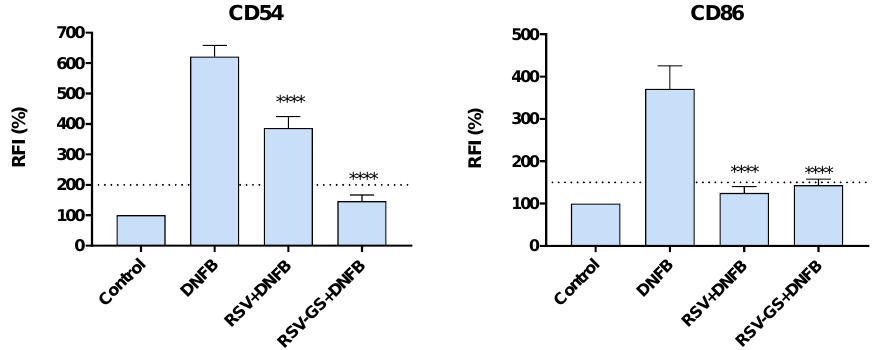
Figure 2. Anti-allergic activity of RSV and RVS-GS toward the maturation of THP-1 cells induced by the allergen DNFB. The relative fluorescence intensity (RFI) of CD54 and CD86 expression was measured. Bar graph presents the mean ± SEM of at least three independent experiments. Dashed line indicates the established thresholds for CD54 (200%) and CD86 (150%) markers. The comparisons were performed using one-way ANOVA analysis, with Dunnett’s multiple comparison post-test, where p < 0.05 was considered significant compared with the DNFB. **** p < 0.0001: significantly different compared to the DNFB.